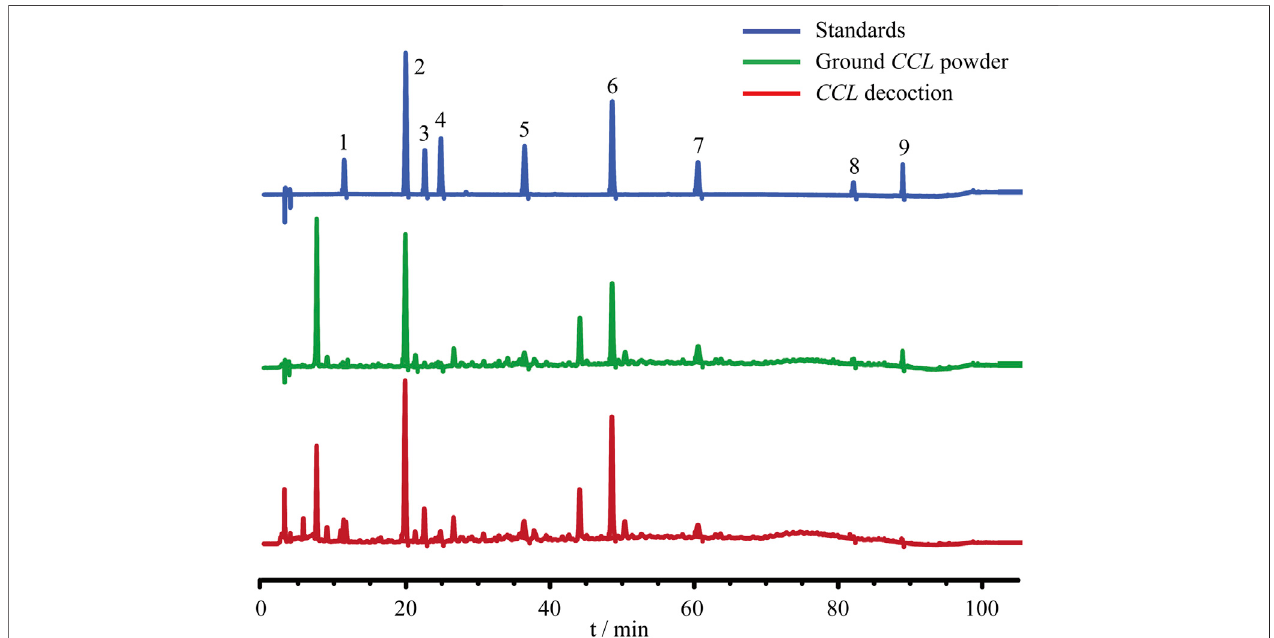
FIGURE 1 | Quality control analysis of CCL. For the quality control purpose, HPLC analysis was performed to estimate the content of neochlorogenic acid, chlorogenic acid, cryptochlorogenic acid, caffeic acid, p-coumaric acid, hyperoside, astragaline, quercetin and kaempferol in ground CCL powder and CCL decoction. The detection wavelength was set at 328 nm. Peak detection and peak area calculation was performed using Chemstation software.